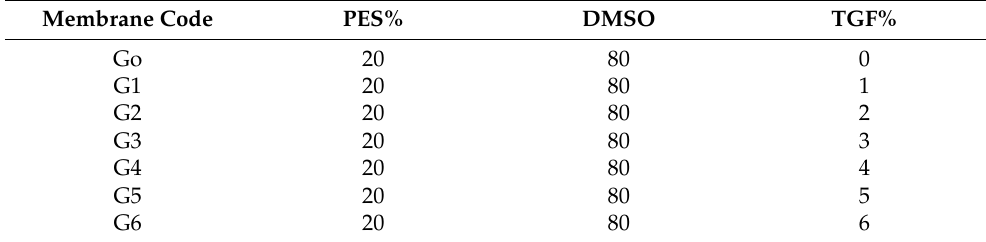
Table 1. Composition of the prepared casting solutions of PES/TGF membranes. Membrane